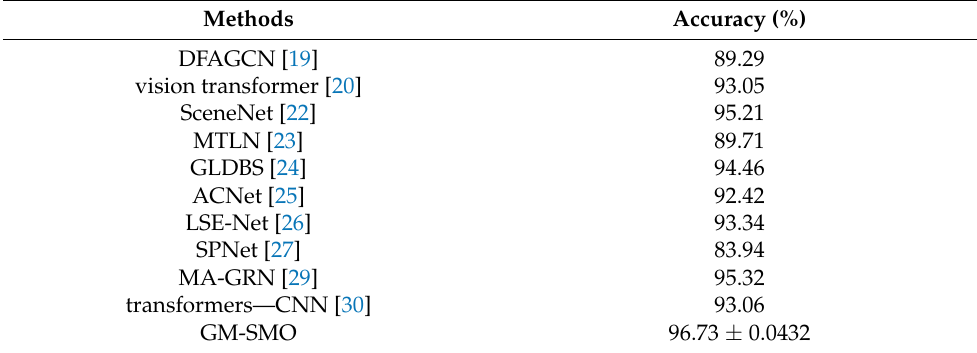
Table 7. GM-SMO method comparison with existing methods on NWPU45